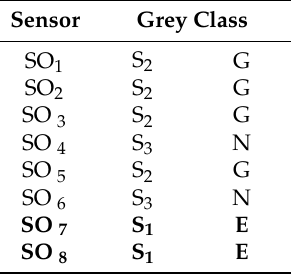
Table 9. Clustering